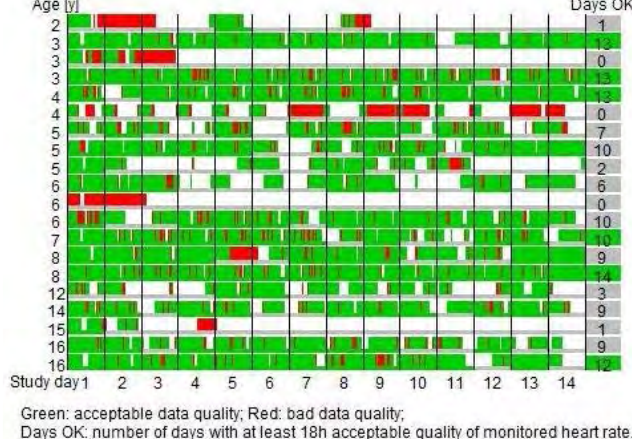
Figure 1: Primary outcome (heart rate) of all 20 patients ordered by age, per study